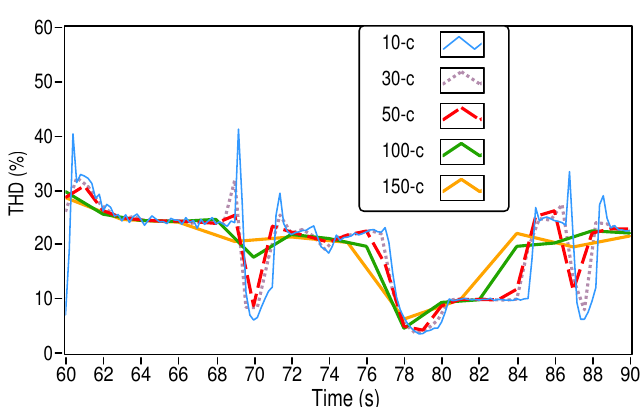
Figure 9. Current THD results measured over 10 cycles and aggregated over 30, 50, 100 and 150 cycles representing 60 to 90 s time intervals.